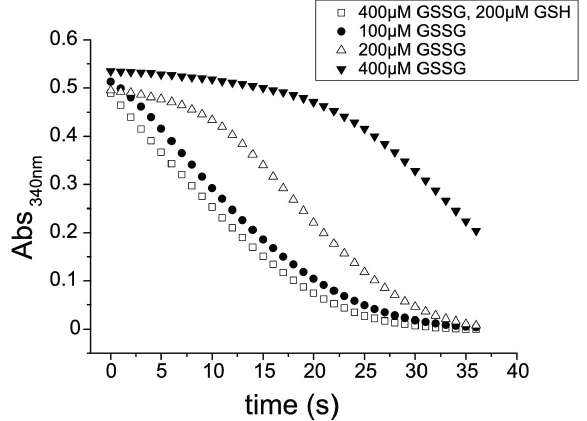
Figure 4. Hysteretic behavior of GR activity of TGR. Full-time courses obtained at different conditions are shown. In all cases constant nicotinamide adenine dinucleotide phosphate, reduced form (NADPH) and enzyme concentrations were used and reactions were started by the addition of enzyme. Oxidized glutathione (GSSG) and reduced glutathione (GSH) concentrations varied. GR assays were carried out with the purified TGR at a 2 nM concentration.